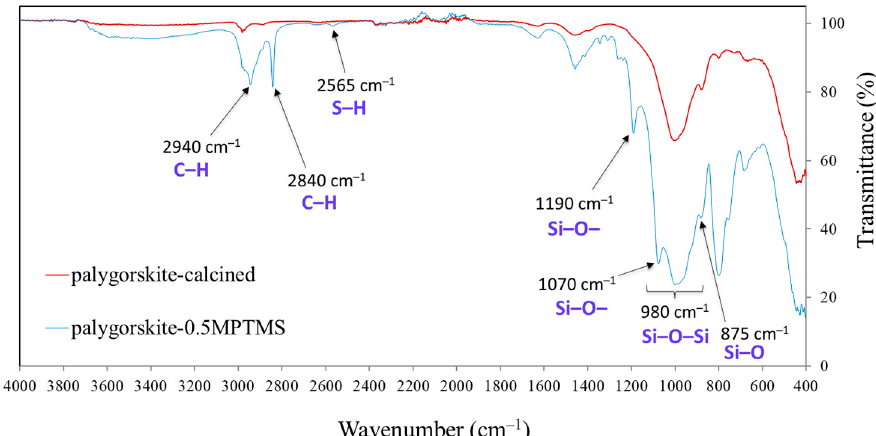
Figure 2. Fourier transform infrared (FTIR) spectra of palygorskite after calcination (red line) and palygorskite after functionalization (palygorskite-0.5MPTMS) (blue line).